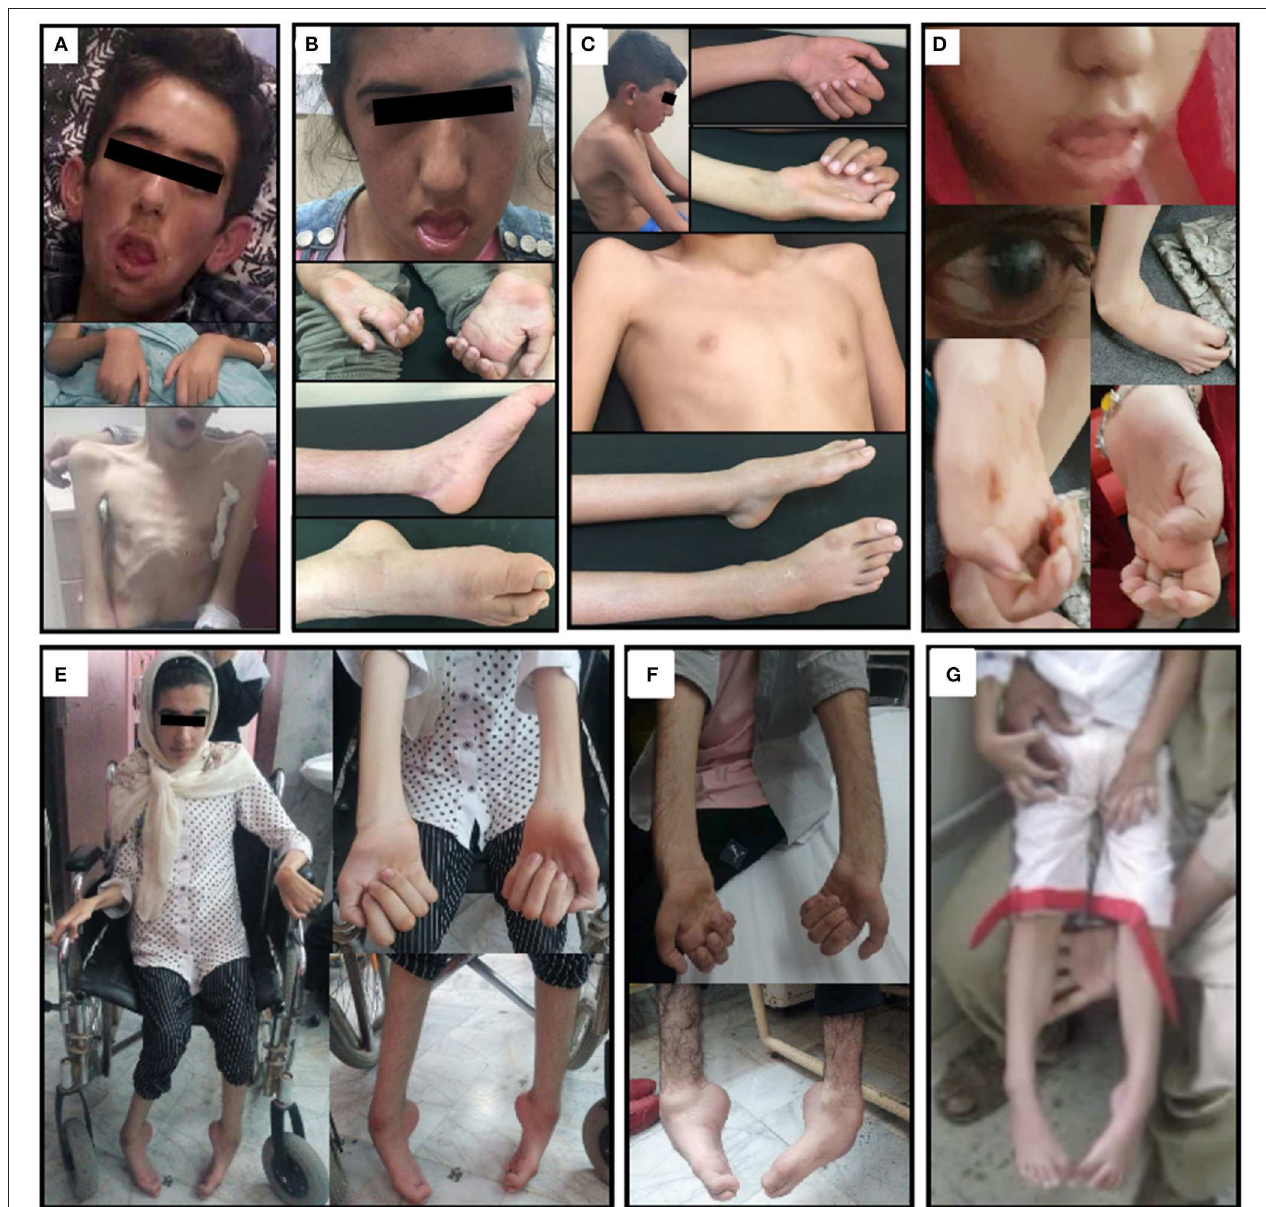
FIGURE 1 | Clinical hallmarks. (A) The clinical picture of patient family 1 II.1 at the age of 18 years showing generalized muscle atrophy, facial weakness, and mild pectus carinatum. (B) Clinical presentation of patient family 1 II.2 at the age of 17 years with facial weakness, progressive neuropathic muscular atrophy in the hands and pes cavus foot deformities. (C) Patient family 1 II.3 at the age of 12 years presenting with thoracic kyphosis, progressive neuropathic muscular atrophy in the hands, mild pectus carinatum and pes cavus foot deformities. (D) Clinical presentation of patient II.3 from family 2 showing facial weakness, clenched hands, club feet, and glaucoma. (E,F) Clinical hallmarks from the affected individuals in Family 3 illustrate the skeletal deformities. (E) Distal muscle atrophy, claw hand deformities, hammertoes, and foot deformities in the wheelchair-bound bound girl (Family 3, Patient II.2). (F) Distal muscle atrophy, claw hand deformities, and foot drop in the elder brother (Family 3, Patient II.1). (G) Clinical presentation of patient family 4 II.3 showed pes cavus foot deformity and muscle weakness and atrophy mainly involving the lower extremity